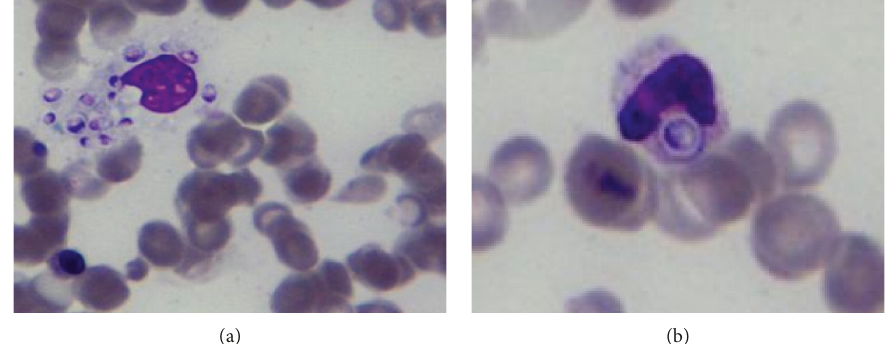
Figure 2: Bone marrow aspirate (a) and peripheral blood smear microscopy (b) showing yeast-like cells of H. capsulatum with a clear halo around them (Jenner–Giemsa stain; 1000x).